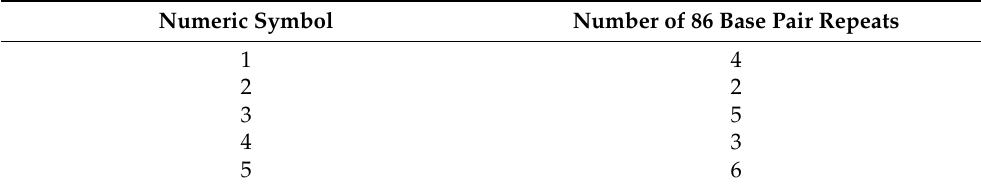
Table 1. The nomenclature used for the polymorphism of a variable number of tandem